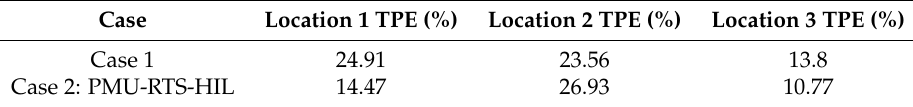
Table 4. Fault detection total prediction